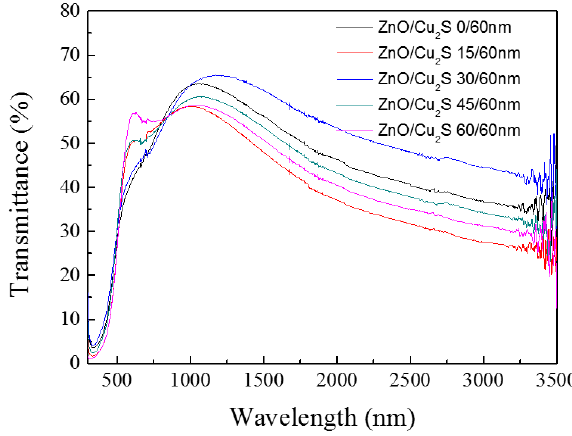
Figure 15. The transmittance diagram of ZnO/Cu 2 S/glass complex films for different thickness.